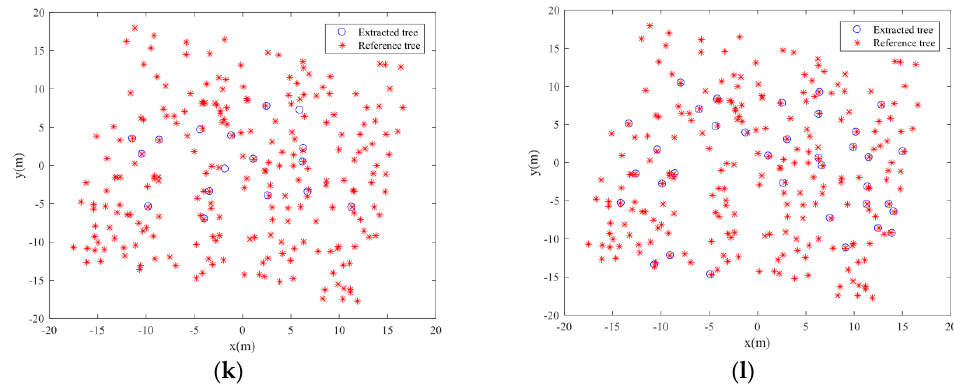
Figure 14. Horizontal locations of the extracted and reference trees for the six plots scanned in both single-scan and multi-scan modes. ( a , b ) are the locations of the extracted stems for Plot 1; ( c , d ) are the locations of the extracted stems for Plot 2; ( e , f ) are the locations of the extracted stems for Plot 3; ( g , h ) are the locations of the extracted stems for Plot 4; ( i , j ) are the locations of the extracted stems for Plot 5; ( k , l ) are the locations of the extracted stems for Plot 6; the first column represents the single-scan mode, while the second column represents the multi-scan mode.